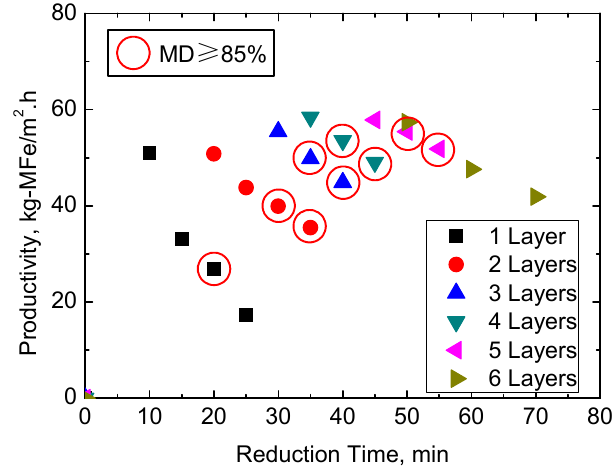
Figure 13. Effects of pellets layers and reduction time on the productivity of metallic iron.